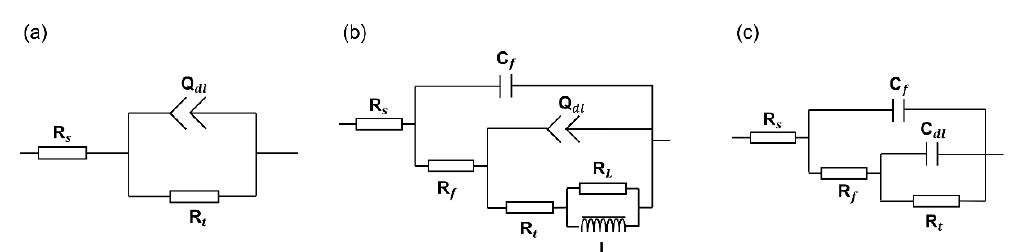
Figure 8. ( a ) Equivalent circuit models for fitting the EIS data without DC currents; ( b ) with i DC ≤ 1mA/cm 2 and ( c ) with i DC = 2 mA/cm 2 . Table 3. Fitted EIS parameters of X80 steel samples after applying various DC densities and strains.